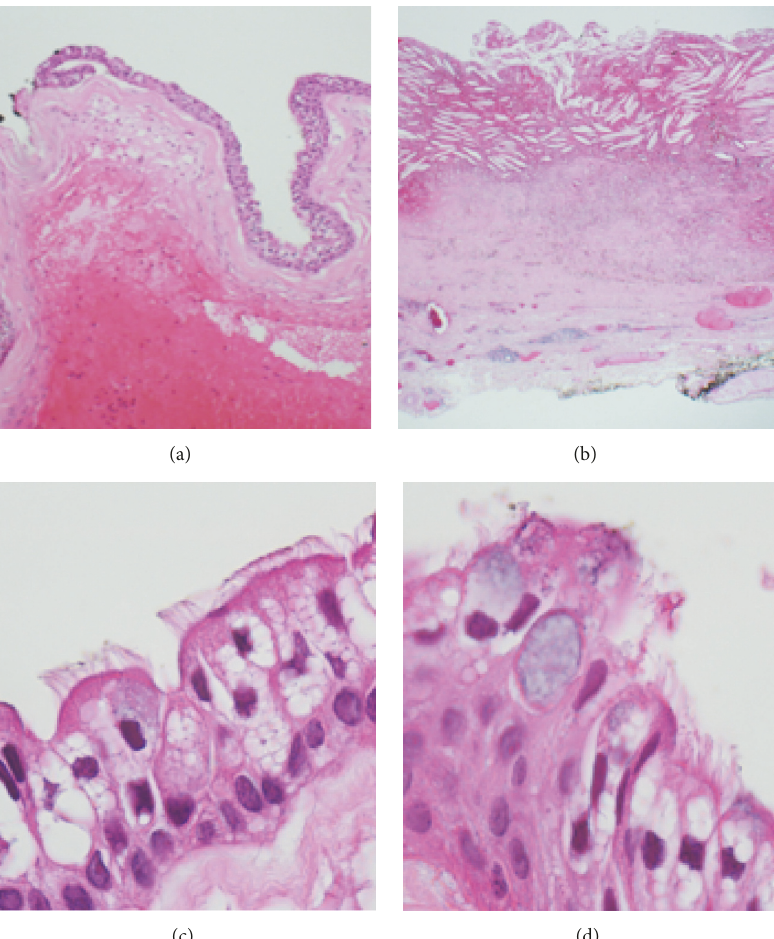
Figure 3: (a) shows the pseudostratified ciliated columnar epithelium with a (b) xanthogranulomatous reaction. (c) Cilia and (d) goblet cells are